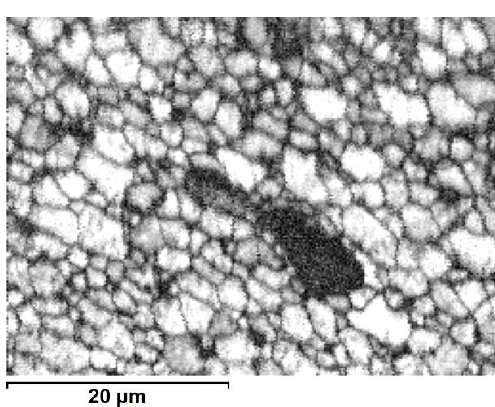
Figure 10. Image based on quality ratio of electron diffraction pattern (SEM/EBSD) from core area (E/224 rpm).